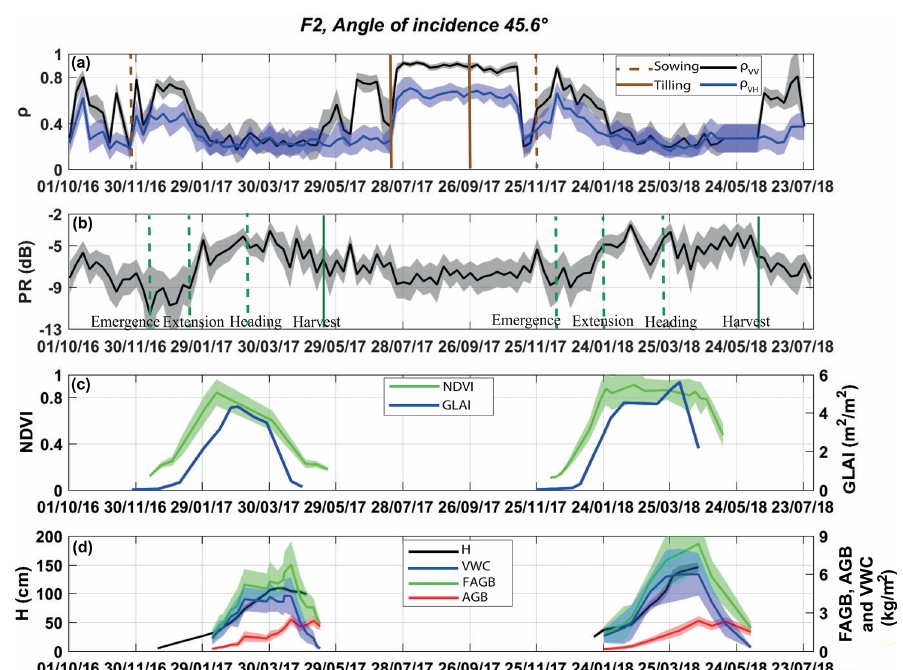
Figure 10. Time series of the interferometric coherence at VV and VH polarizations (a) and the polarization ratio (b) on F2 at a 45.6 ◦ incidence angle during the period from 1 October 2016 to 31 July 2018. The tilling works and phenological stages of wheat are superimposed in panels (a) and (b) , respectively. The NDVI and measured GLAI are displayed in panel (c) . Measured H , FAGB, VWC and AGB are plotted in panel (d) . Time series are presented by mean values (solid lines) and standard deviations (shading surrounding the solid lines).